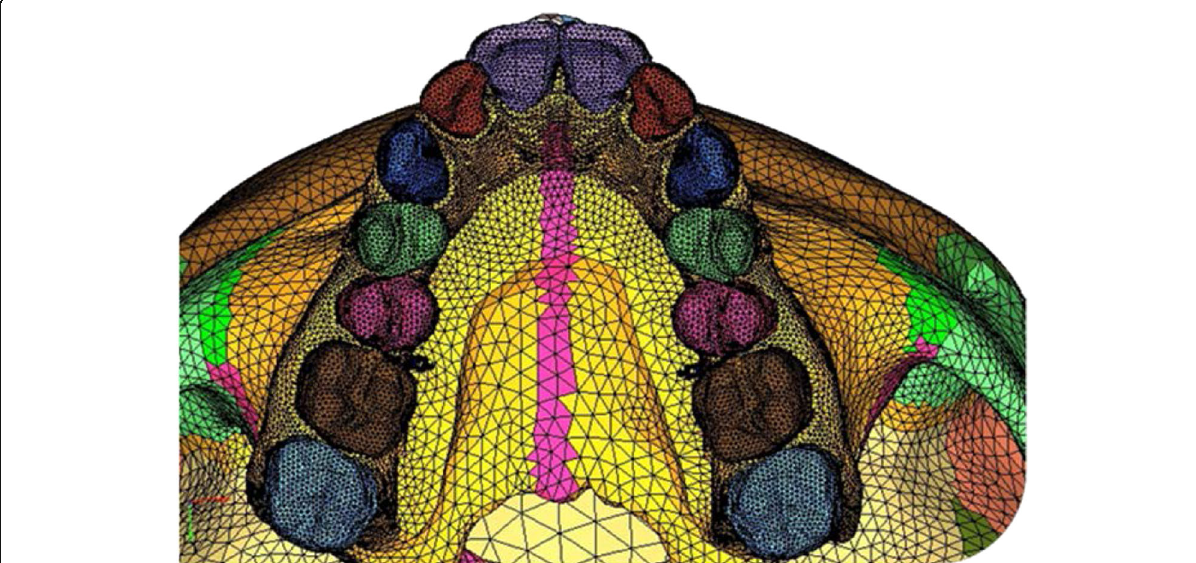
Fig. 4 Finite element model of comprising of